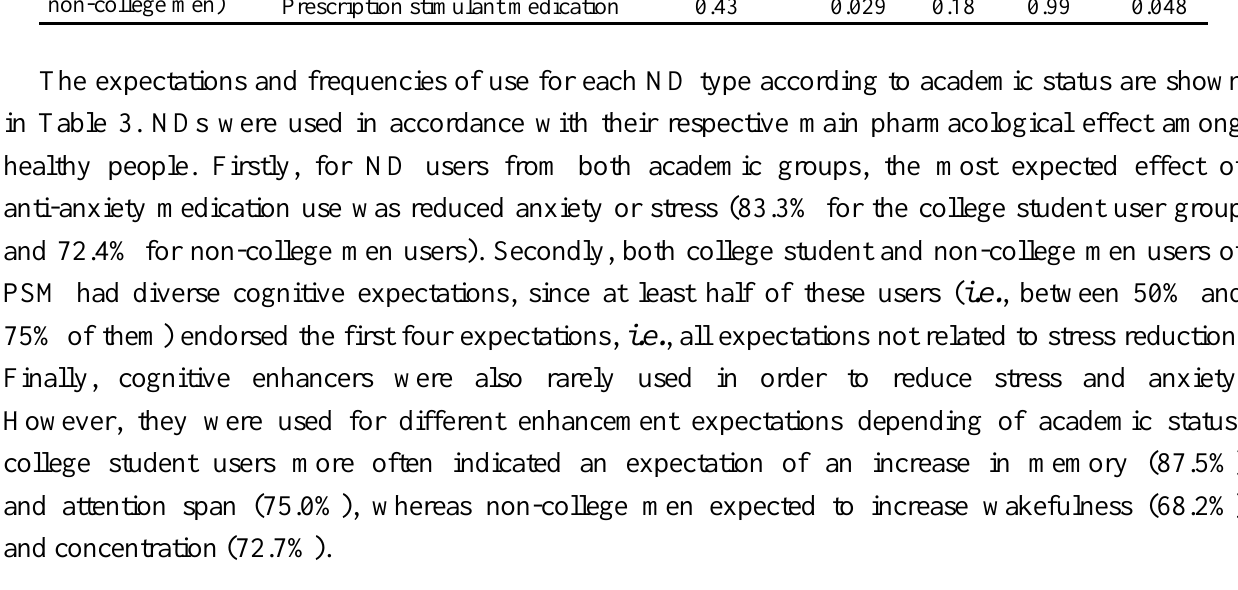
Table 3. Proportion of neuroenhancement drug users and annual frequency of use depending on expectation and academic